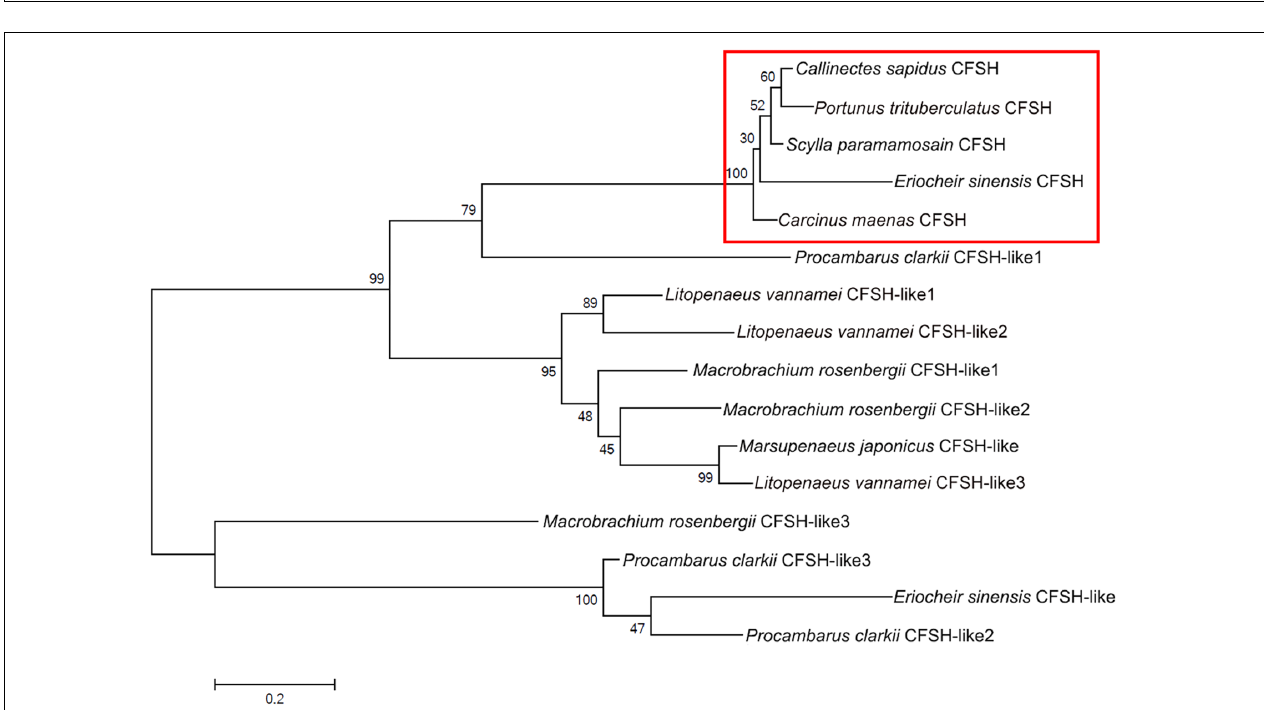
FIGURE 2 | Sequence alignment of deduced amino acid sequences of CFSH cDNAs of brachyuran crabs. Note the conservation of CFSH in brachyuran crabs. Conserved residues are indicated by the black highlights. The signal peptide is highlighted by a black box. The cleavage site (KR) and the domain IL-17 are boxed in red.